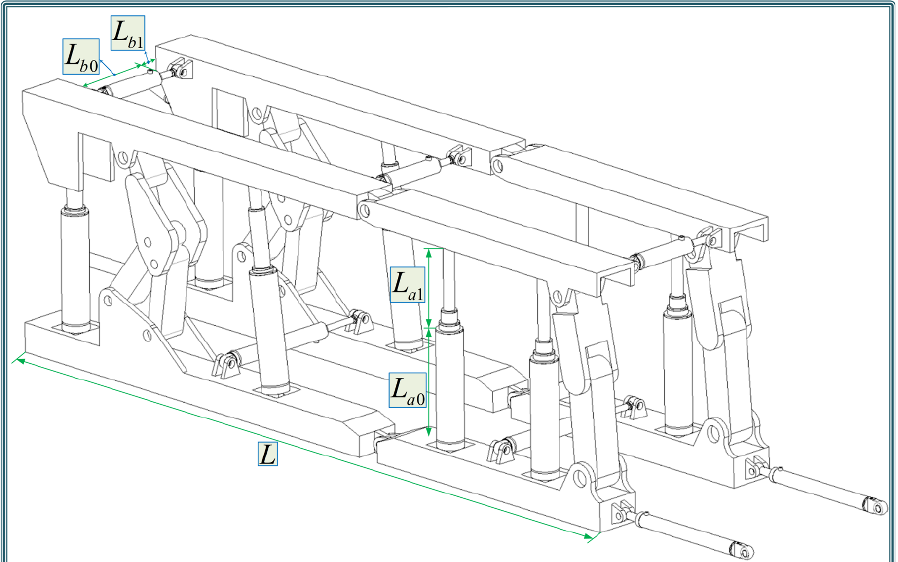
Figure 4. The geometrical dimensions of the core structure of the ESR.